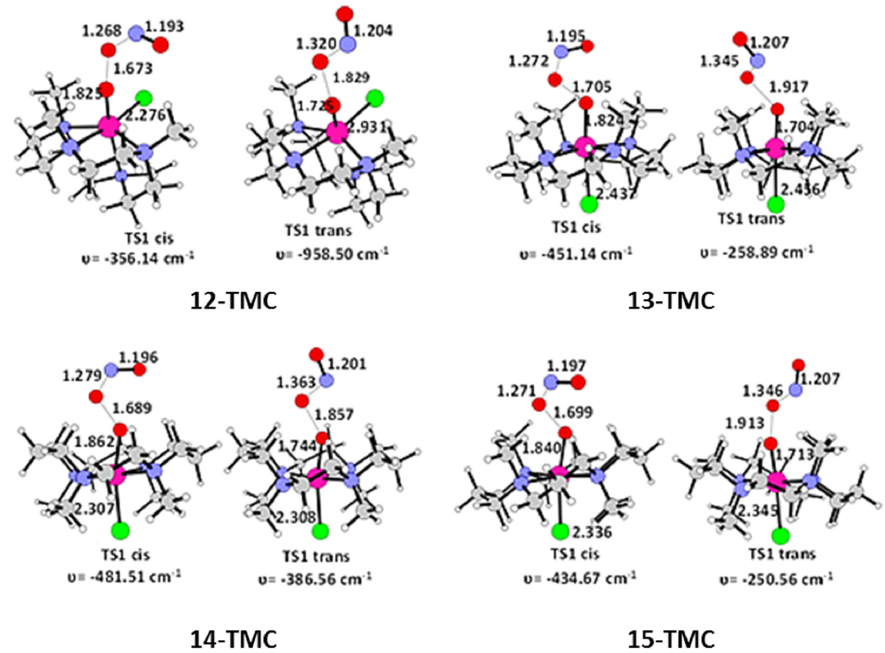
Figure 3. Optimized structures of cis and trans isomers of the first transition state (TS1) for all the investigated ligands along with the main geometrical parameters and imaginary frequency values. Selected bond lengths are in Å. Oxygen (red), chlorine (green), carbon (silver), nitrogen (azure), chromium (hot pink).